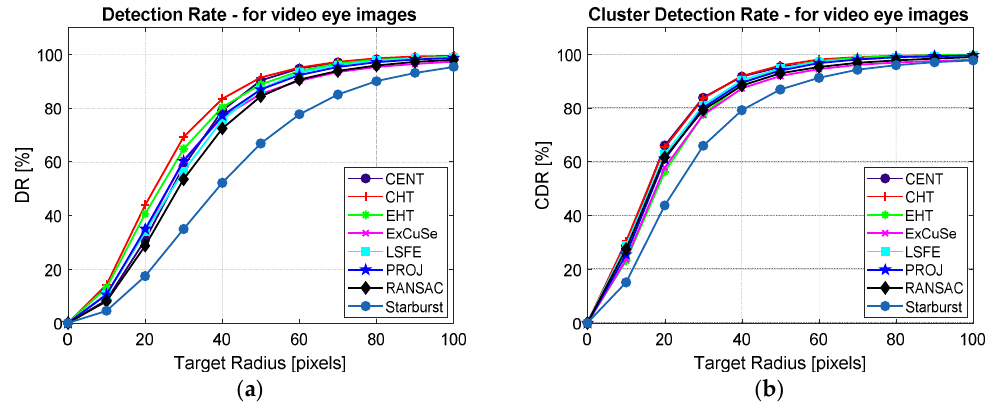
Figure 14. ( a ) Detection rate and ( b ) cluster detection rate depending on target area radius for all studied algorithms for real-time applications.